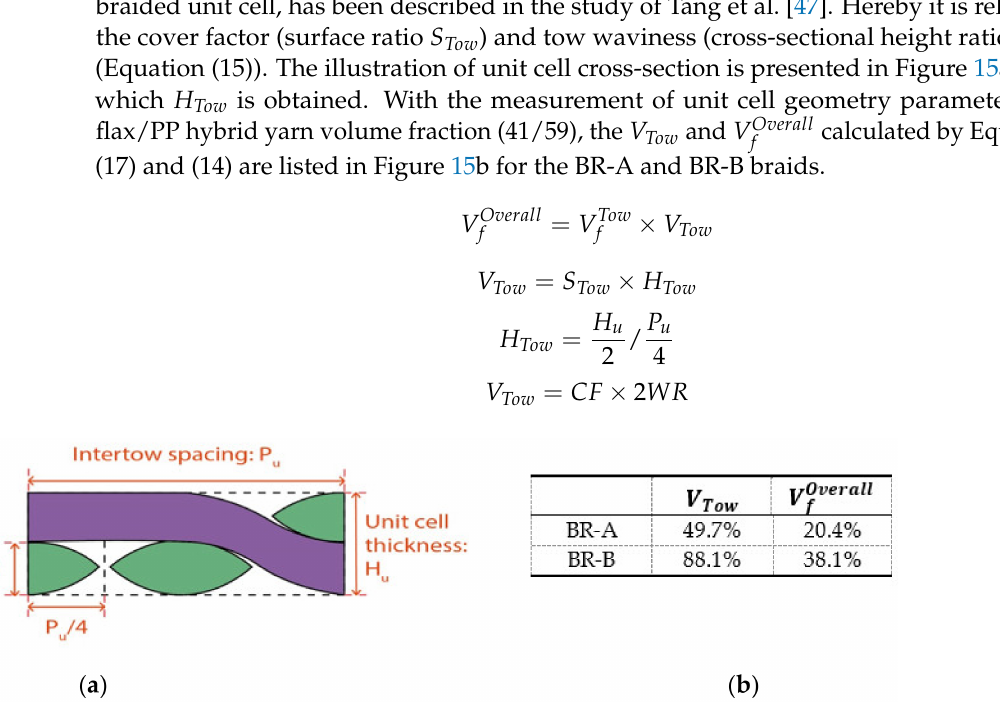
Figure 15. ( a ) Cross-section of the unit cell and ( b ) tow volume fraction and fiber volume fraction of the braided